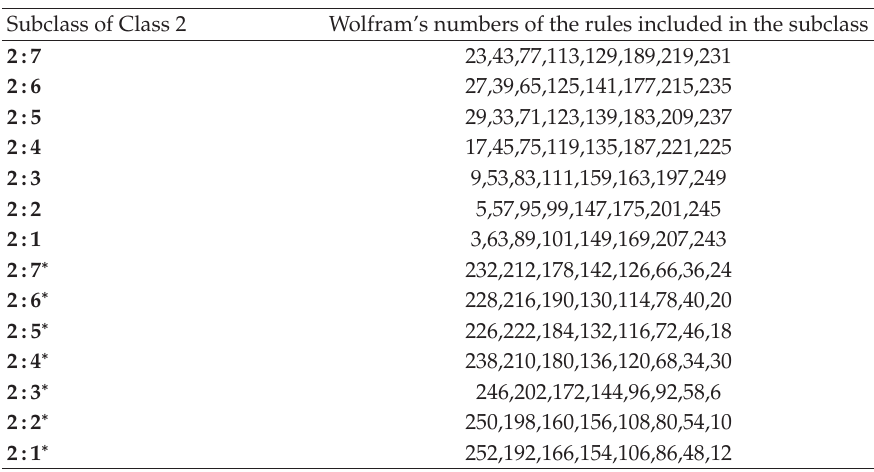
Table 6: Subclassification of Class 2